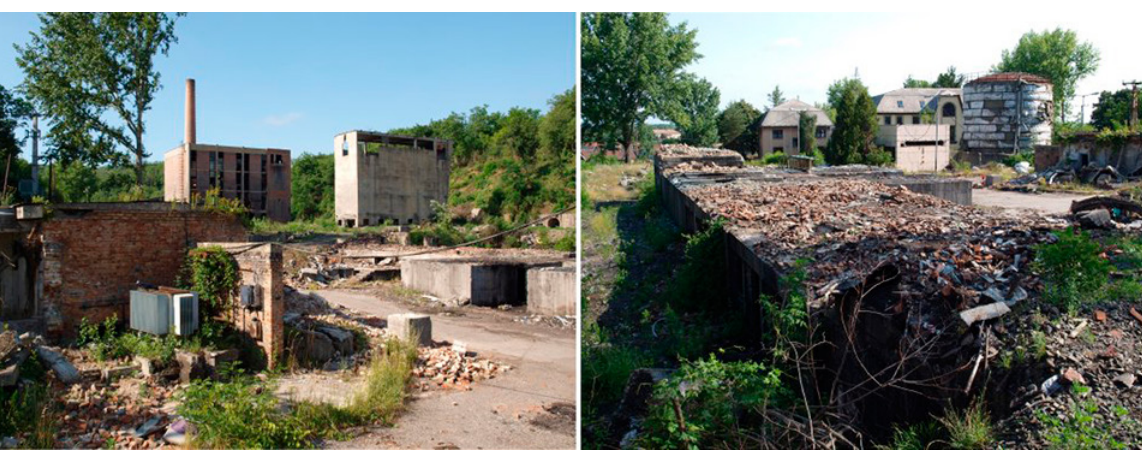
Fig. 3. Left: Transformator station (in front), the boiler-house and the coal-pillbox (background); right: demolited coal-press (in front) and the bitumen